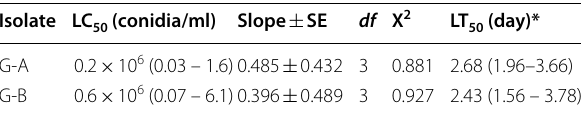
Table 1 Lethal G-A and G-B Beauveria bassiana